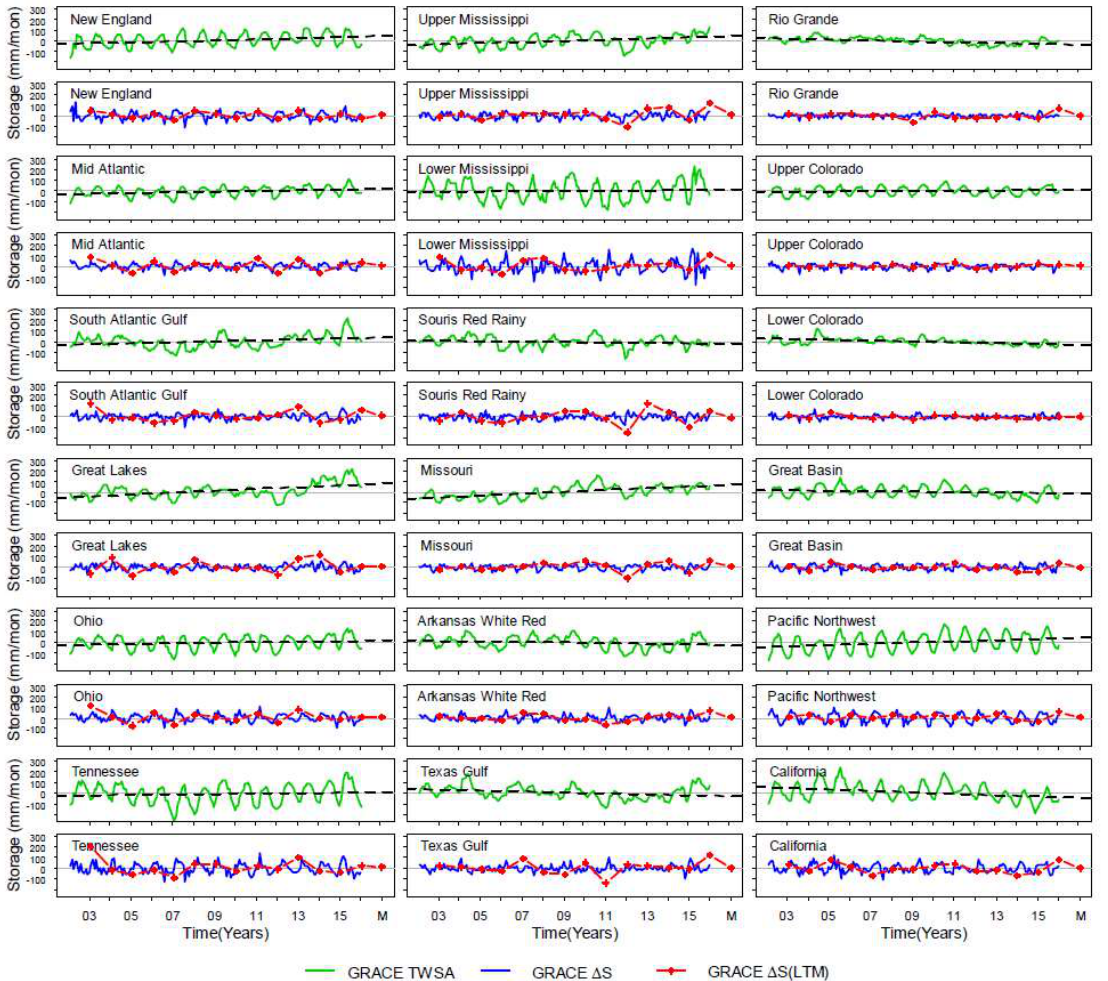
Figure 2. Time-series plots of monthly GRACE TWSA for the HUC2 surface basins in conterminous United States (CONUS) during 2003–2016. Dashed lines indicate the slope and decadal trend. LTM stands for long term for annual ( ∆ S ANN ) and decadal ( ∆ S DM ) change in storage. The “M” in x-axis represents a decadal time scale.